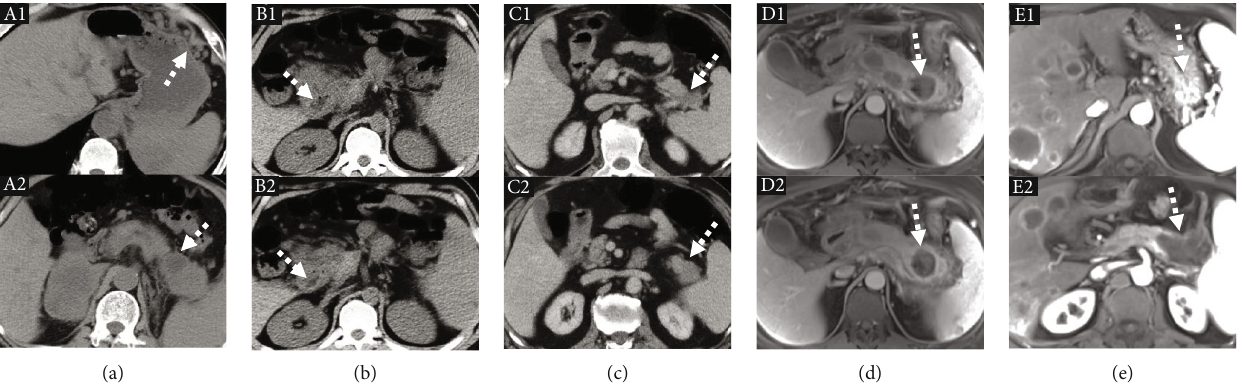
Figure 1: Images regarding pancreatic lesions in fi ve LPSH patients. (a) Plain abdominal CT of case 1 (TL) demonstrating multiple distorted soft issue mass densities in the left upper abdomen (A1, white dotted arrow) and a cystic lesion in the pancreatic tail (A2, white dotted arrow). (b) Plain abdominal CT of case 2 (YC) demonstrating a distorted pancreatic head with local hypodensity (B1 and B2, white dotted arrows). (c) Contrast-enhanced abdominal CT of case 3 (WZ) demonstrating a mass in the pancreatic tail (C1 and C2, white dotted arrows). (d) Contrast- enhanced abdominal MR of case 4 (JH) demonstrating acute hemorrhagic necrotizing pancreatitis with pancreatic pseudocyst (D1 and D2, white dotted arrows). (e) Contrast-enhanced abdominal MR of case 5 (HW) demonstrating multiple gastric and splenic varices (E1, white dotted arrow) and pancreatic cystadenocarcinoma in the pancreatic tail (E2, white dotted arrow).